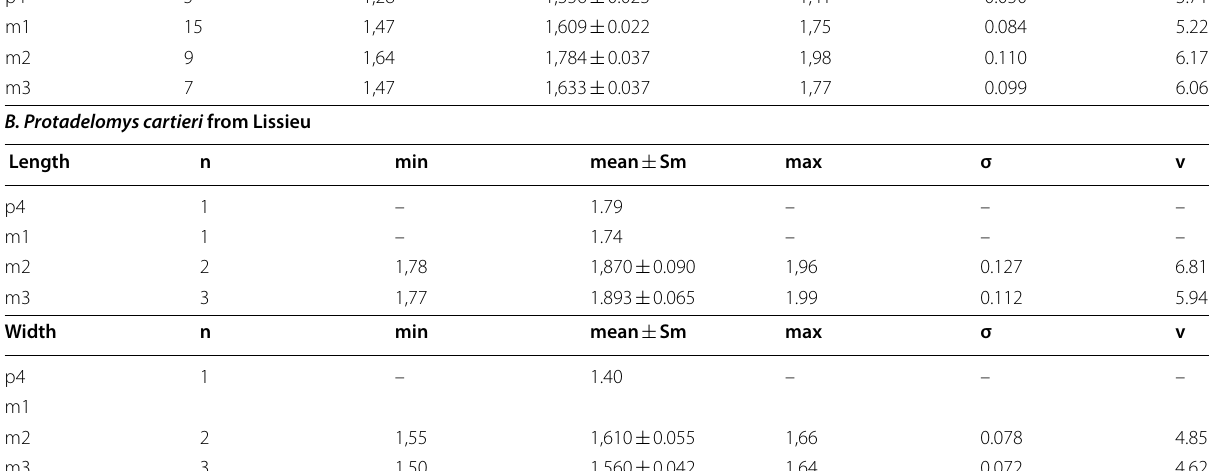
Sm σ/ √ n; v 100 σ/average L or W): A. of the different ± = =